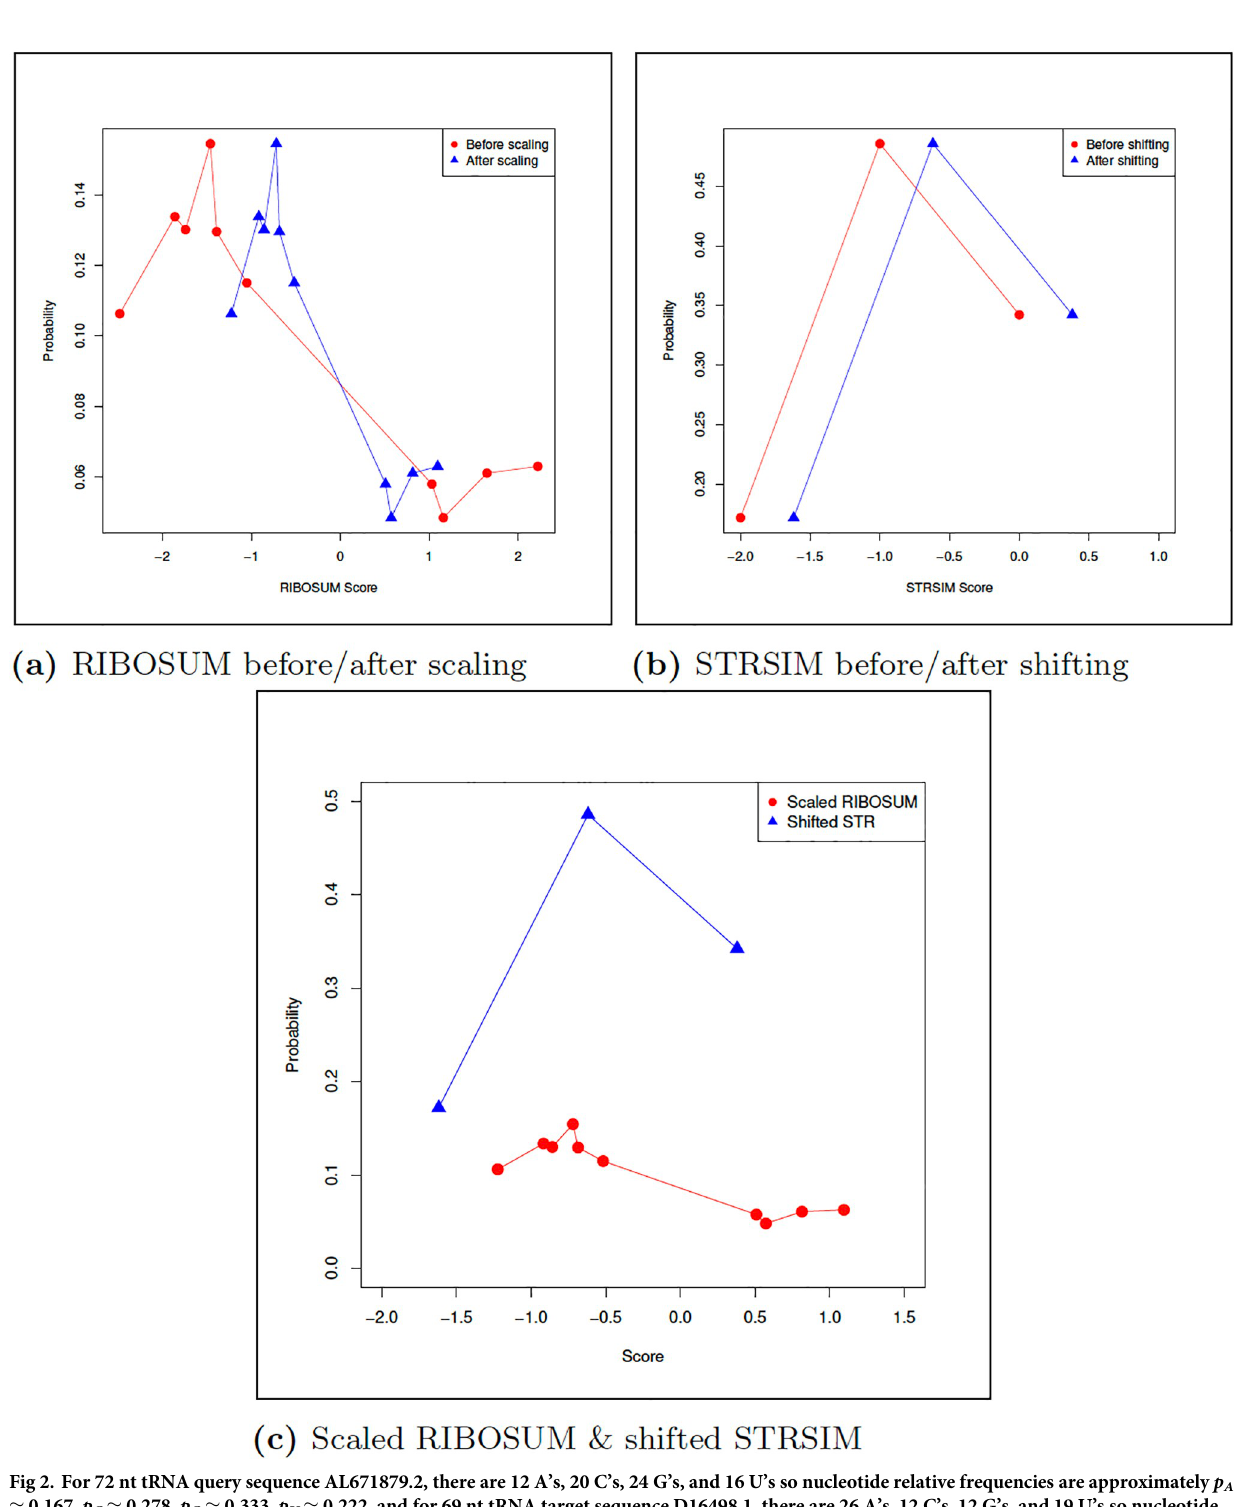
Fig 2. For 72 nt tRNA query sequence AL671879.2, there are 12 A’s, 20 C’s, 24 G’s, and 16 U’s so nucleotide relative frequencies are approximately p A � 0.167, p � 0.278, p � 0.333, p � 0.222, and for 69 nt tRNA target sequence D16498.1, there are 26 A’s, 12 C’s, 12 G’s, and 19 U’s so nucleotide C G U relative frequencies are approximately p A � 0.377, p C � 0.174, p G � 0.174, p U � 0.275. From the base pairing probabilities computed by RNAfold -p , we have query frequencies p ( = 0.3035, p • = 0.3930, p ) = 0.3035 and target frequencies p ( = 0.2835, p • = 0.433, p ) = 0.2835, so by Eqs (10), (11), (13) and (14), we have μ seq = − 0.9098, σ seq = 1.5871 and μ str = − 0.8298, σ str = 0.6967. By Eqs (15) and (16), we determine that RIBOSUM scaling factor α seq = 0.4390 and α str = 0.4305 (all values shown rounded to 4-decimal places). Using these values, the scaled RIBOSUM mean is now − 0.39936, now equal to the shifted